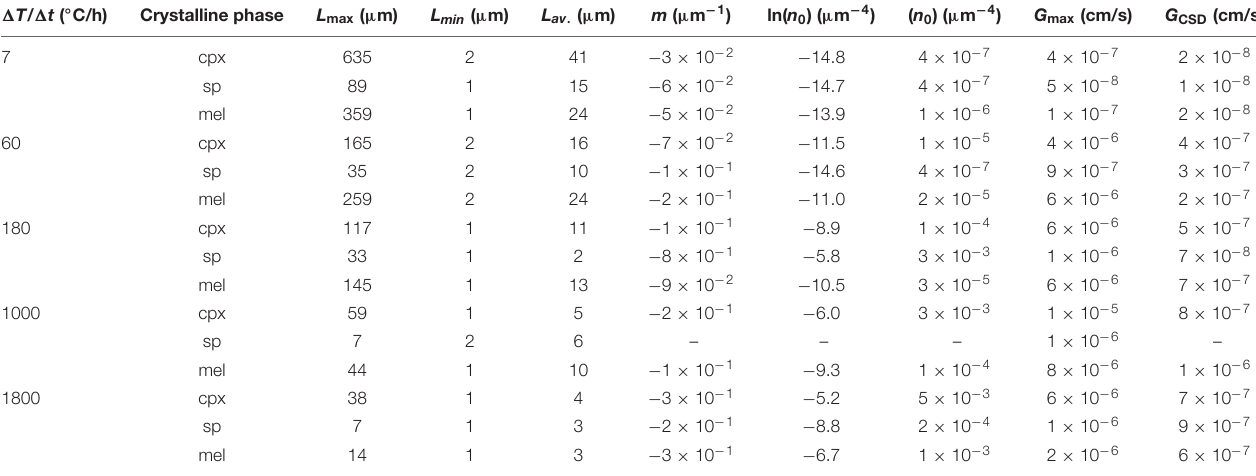
TABLE 5 | 2D maximum ( L max ), minimum ( L min ) and averaged ( L av , ) crystal lengths, CSDs parameters ( m and n 0 ), maximum ( G max ) and average ( G CSD ) growth rates. (cid:49) T / (cid:49) t ( ◦